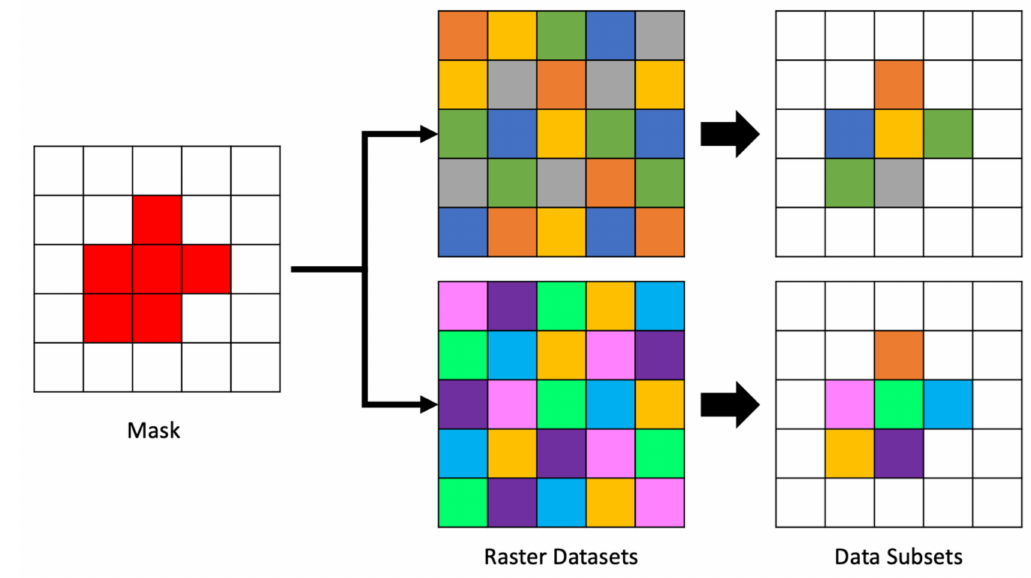
Figure 5. Appling a Mask to Many